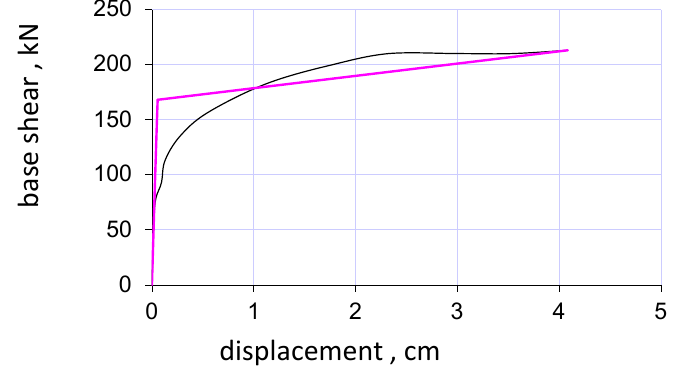
Figure 9. The two–line graph resulting from the cyclic loading curve.